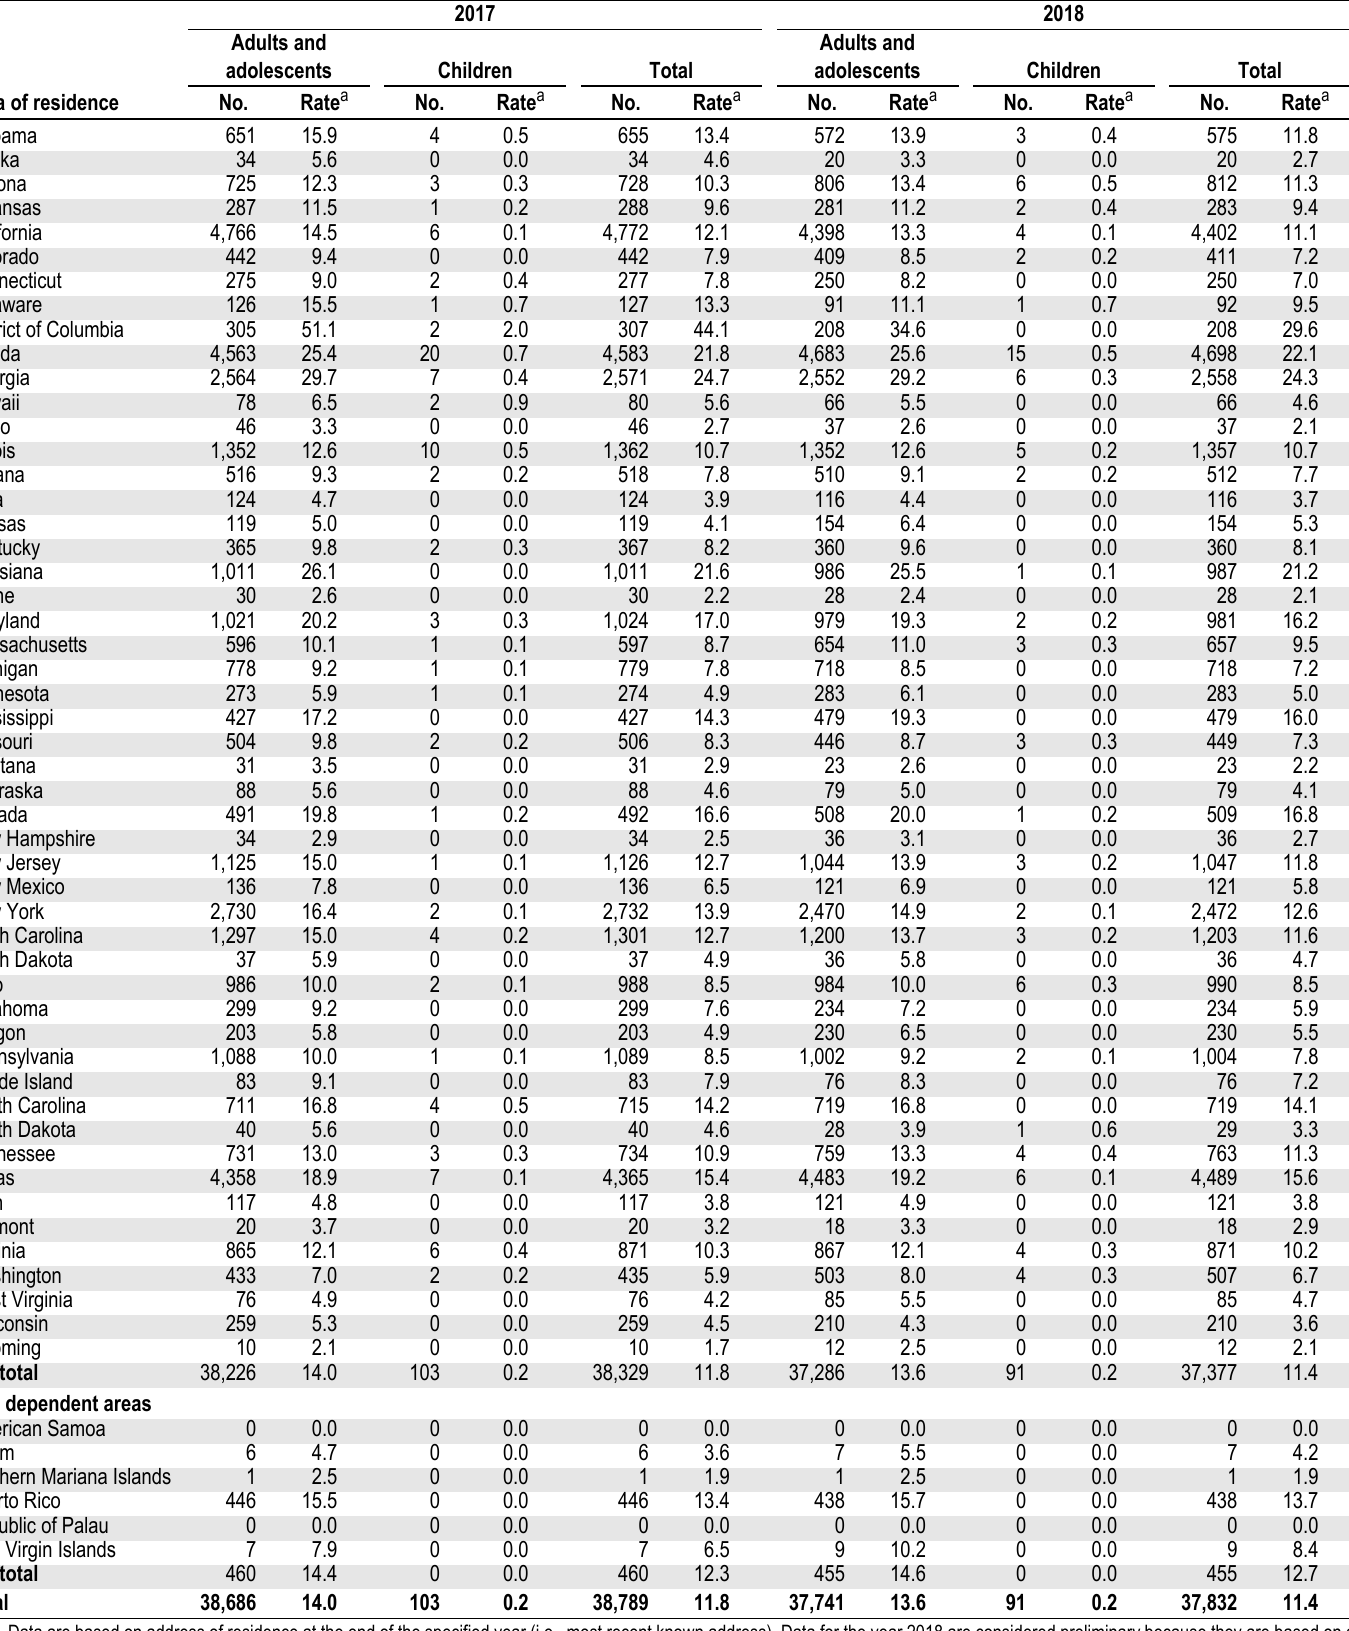
Table 26. Diagnoses of HIV infection, by area of residence, 2017 and 2018—United States and 6 dependent